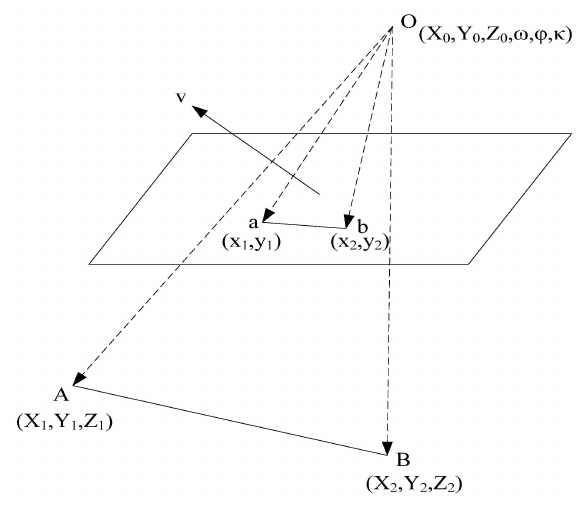
Figure 2. Coplanarity of corresponding 2D and 3D line